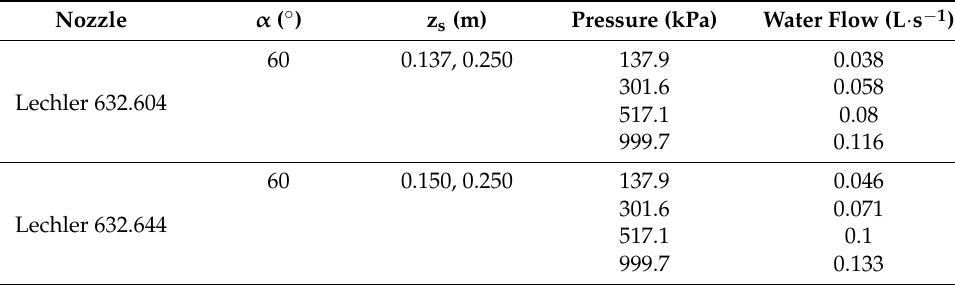
Table 1. Experimental conditions for impingement